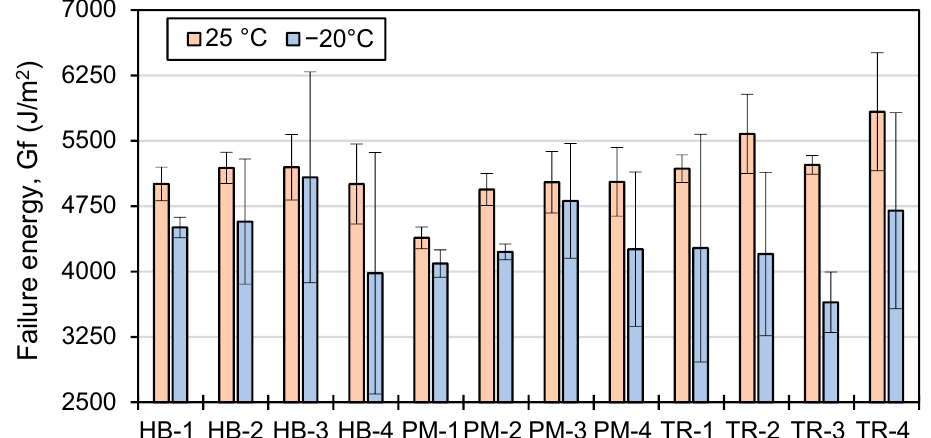
Figure 16. Work of failure (W f ) results at 25 °C ( n = 3) and − 20 °C ( n = 3).